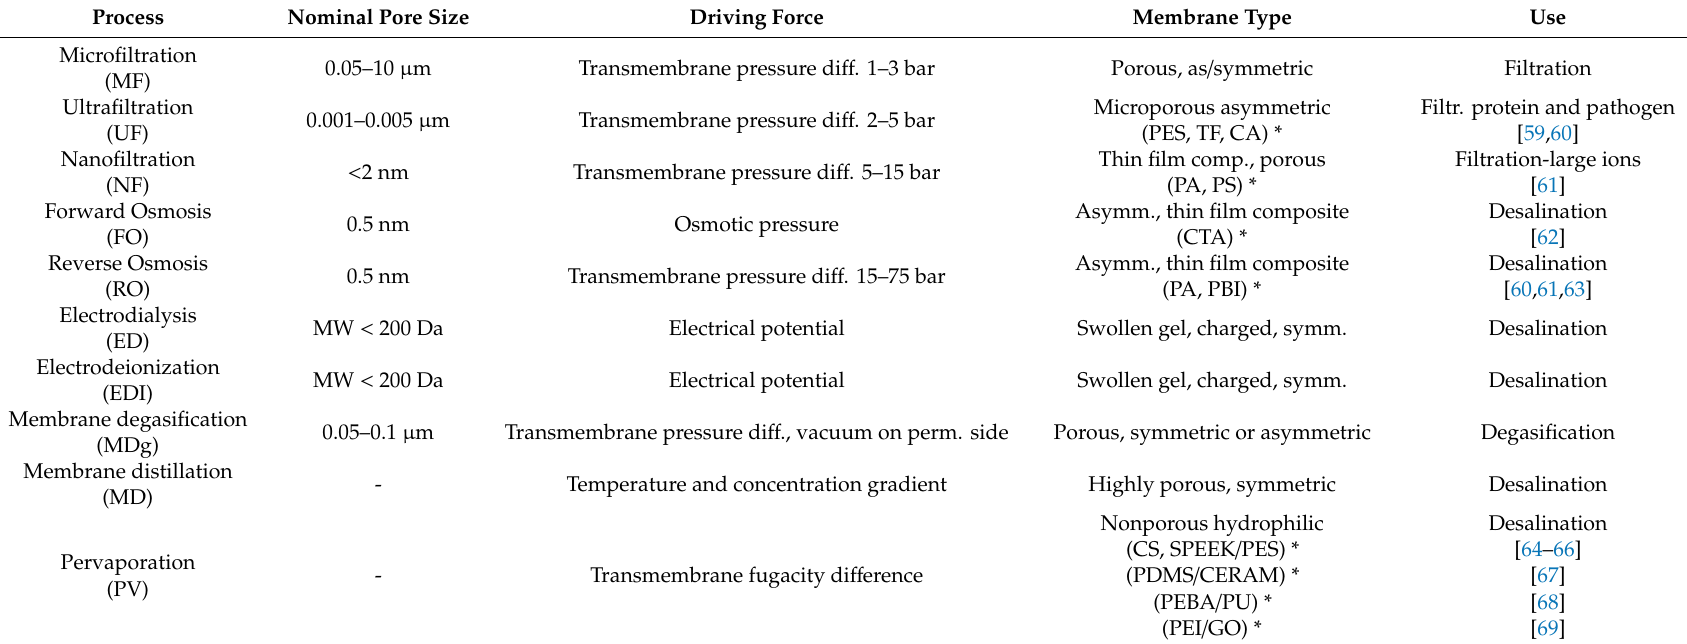
Table 2. Membrane processes in water treatment